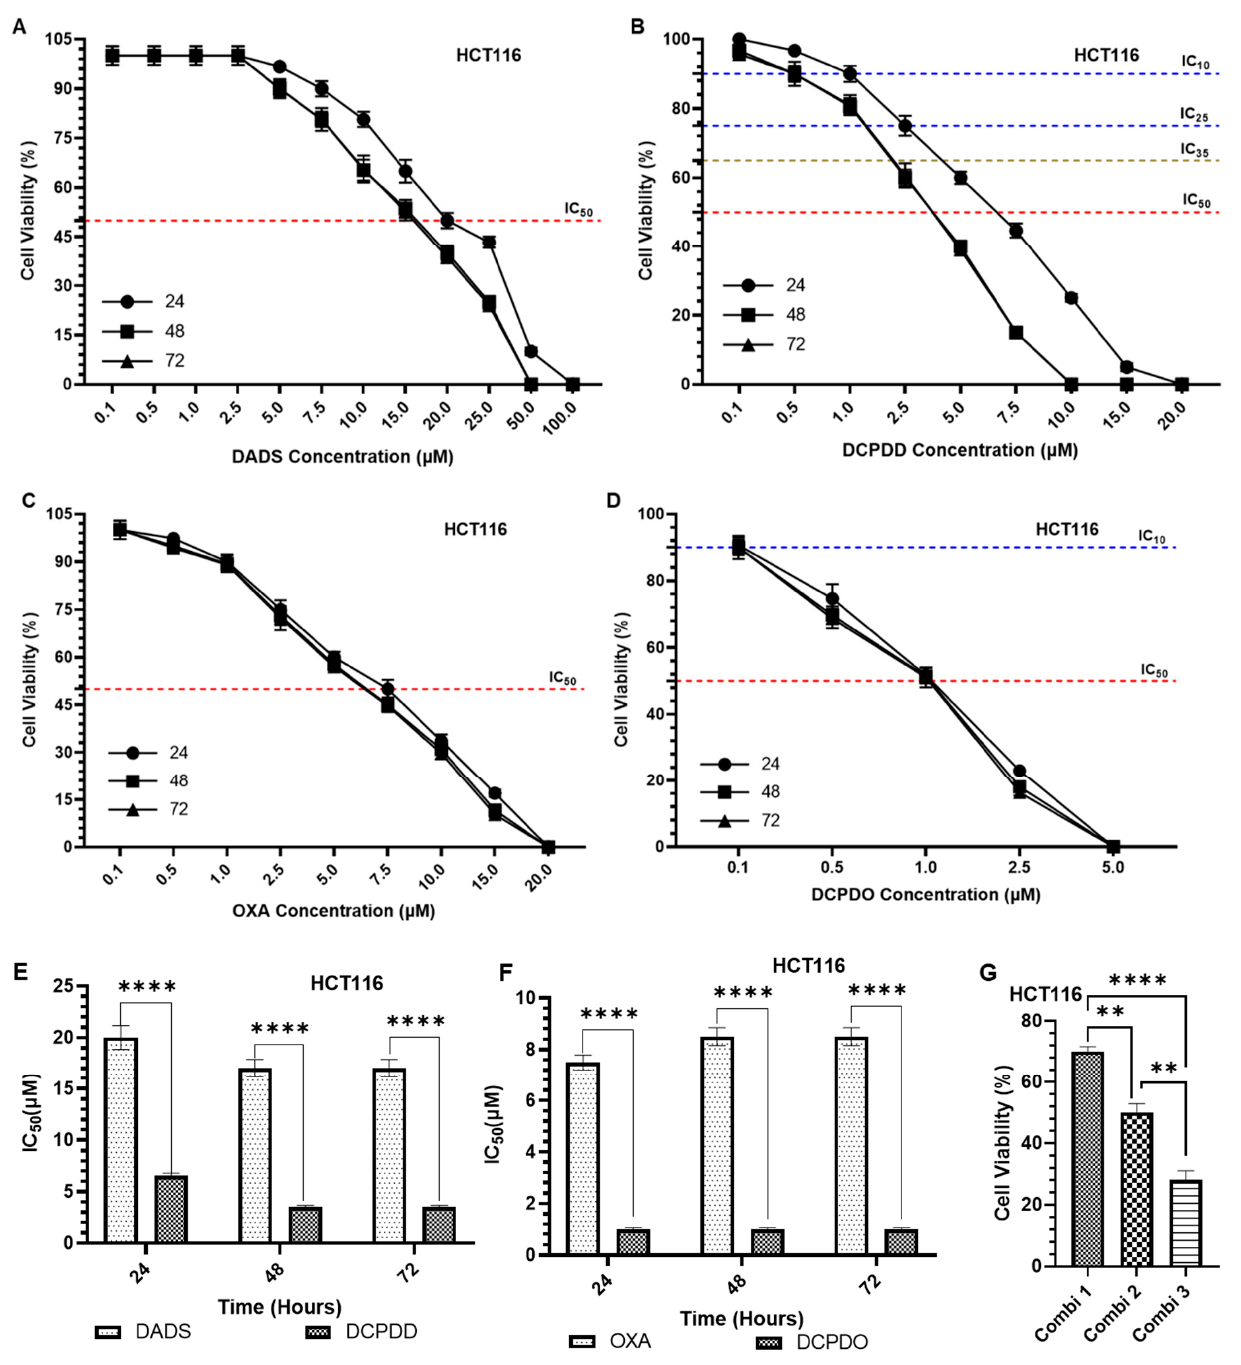
Figure 5. Effect of DADS, DCPDD, OXA, and DCPDO at varying concentrations on cellular proliferation by cell cytotoxicity assay at 24 h, 48 h, and 72 h in HCT116 colon cancer cells ( A ), DADS ( B ), DCPDD, ( C ) OXA, ( D ) DCPDO, ( E ) IC 50 of DADS and DCPDD, ( F ) IC 50 of OXA and DCPDO, ( G ) and cell Viability by combinations of DCPDD and DCPDO. The values are expressed as mean ± SE of three independent experiments. ** Significant difference between the treated groups, p -value < 0.01, **** Significant difference between the treated groups, p -value < 0.0001.